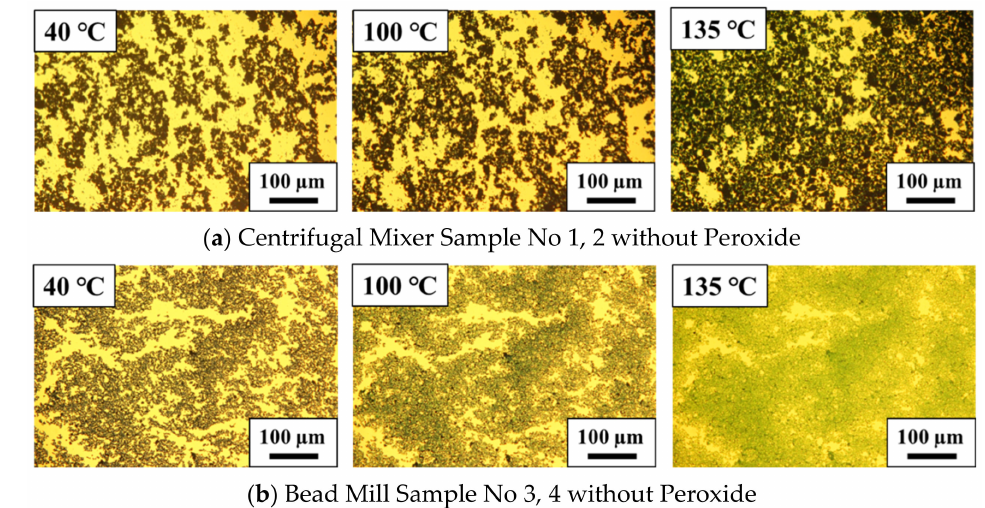
Figure 4. Optical microscopy images of ( a ) centrifugal mixer samples 1 and 2 and ( b ) bead mill samples 3 and 4. All samples were made without a